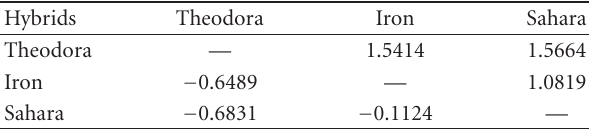
Table 1: Matrices of average taxonomic distance (above diagonal) and product moment correlation (below diagonal) for hybrids.